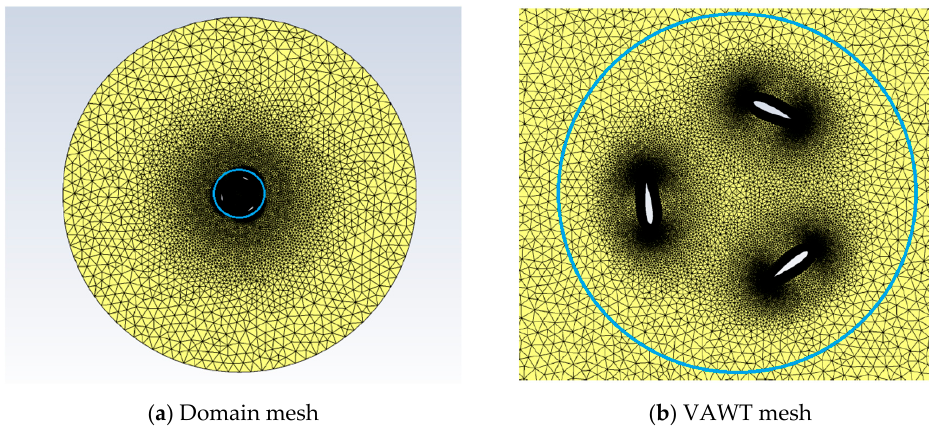
Figure 1. Mesh for isolated VAWT: ( a ) Domain mesh and ( b ) VAWT mesh.